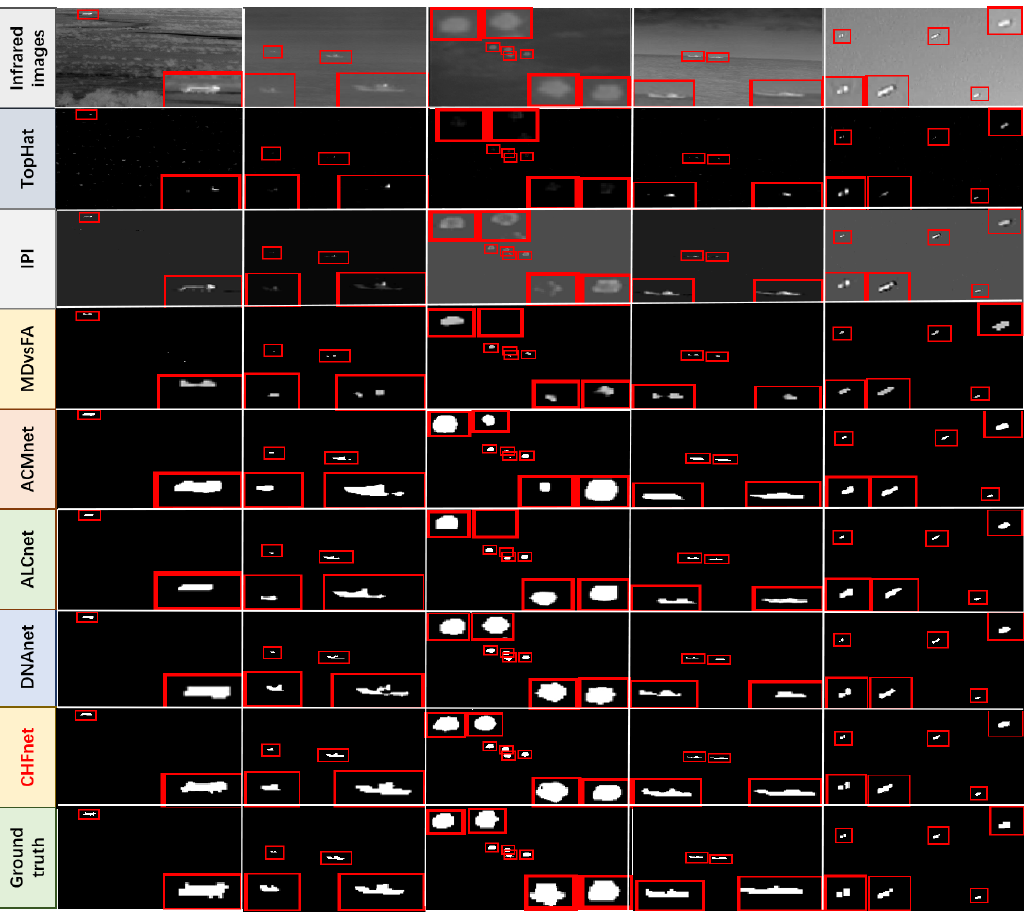
Figure 5. Visual results of different methods for IRSTD. Red boxes are the location of the targets. Closed-up views are shown.